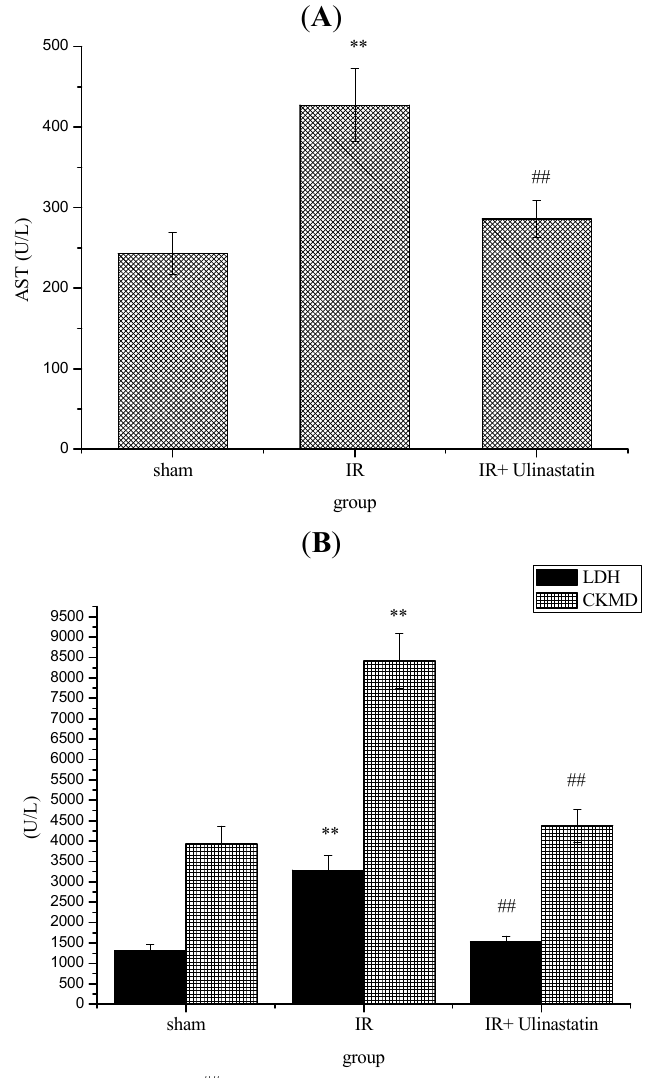
Figure 1. Effect of ulinastatin on serum AST ( A ) LDH and CKMD; ( B ) Activities in three